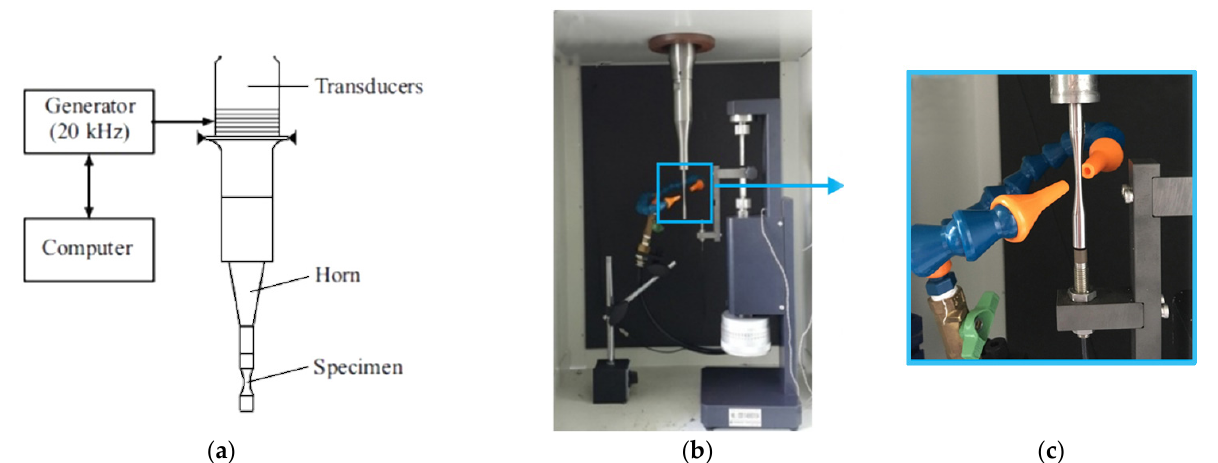
Figure 3. ( a ) Schematic and ( b ) overview of the ultrasonic resonance loading machine Shimadzu USF–2000 under cycle testing; ( c ) air cooling system [48].